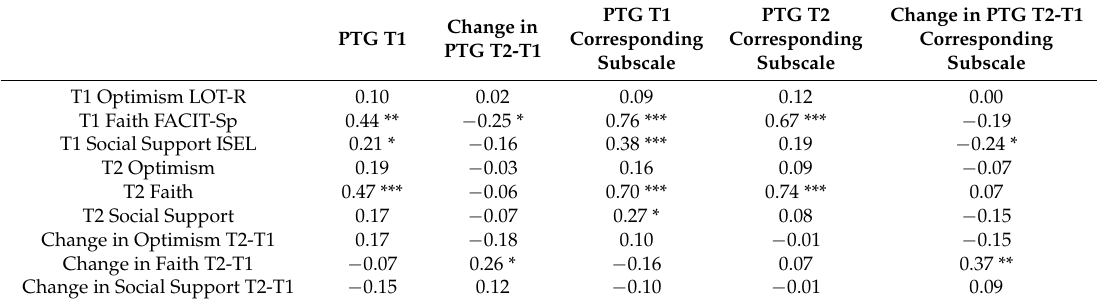
Table 4. Bivariate Correlational Analyses of T1 Post Traumatic Growth Inventory (PTGI) and PTGI corresponding subscales with psychosocial resources (Cross-sectional and change). PTG T2 Change in PTG T2-T1 PTG T1 Change in Corresponding Corresponding PTG T1 Corresponding PTG T2-T1 Subscale Subscale Subscale T1 Optimism LOT-R 0.10 0.02 0.09 0.12 0.00 T1 Faith FACIT-Sp 0.44 ** − 0.25 * 0.76 *** 0.67 *** − 0.19 T1 Social Support ISEL 0.21 * − 0.16 0.38 *** 0.19 − 0.24 * T2 Optimism 0.19 − 0.03 0.16 0.09 − 0.07 T2 Faith 0.47 *** − 0.06 0.70 *** 0.74 *** 0.07 T2 Social Support 0.17 − 0.07 0.27 * 0.08 − 0.15 Change in Optimism T2-T1 0.17 − 0.18 0.10 − 0.01 − 0.15 Change in Faith T2-T1 − 0.07 0.26 * − 0.16 0.07 0.37 ** Change in Social Support T2-T1 − 0.15 0.12 − 0.10 − 0.01